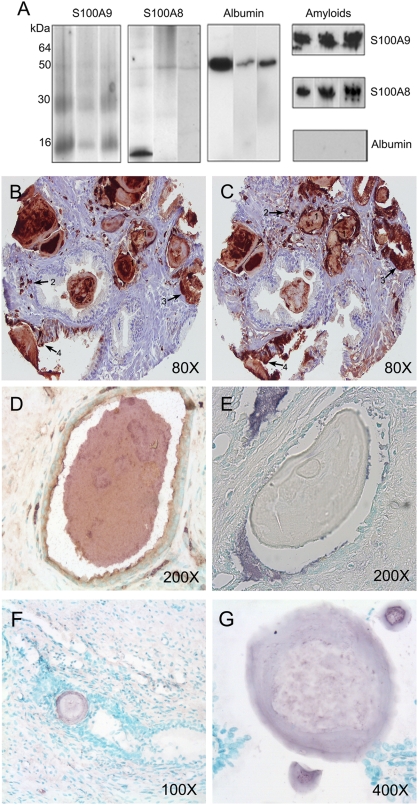
Immunoassays of CA proteinaceous components.(A) Western blots of CA extracts from three representative specimens with S100A9, S100A8 and human serum albumin antibodies; the staining of aggregates in stacking gel with corresponding antibodies is shown in the right column. (B and C) Immunostaining of CA and surrounding tissues with S100A8 and S100A9 antibodies, respectively, shown in brown; the positive S100A8/A9-staining of CA (1), macrophages in stroma (2), macrophages in epithelium tissues (3) and the focal epithelial staining (4) are indicated by numbers and arrows. (D) Co-immunostaining of CA inclusions with anti-S100A8 (shown in purple) and anti-S100A9 antibodies (shown in brown). (E) Lack of CA immunostaining by human serum albumin antibodies (CA body does not display purple colour). (F and G) Immunostaining of the prostate CA inclusions by antibodies towards amyloid fibrils shown in purple with low and high magnification. The magnification is indicated in left lower corner of each image.